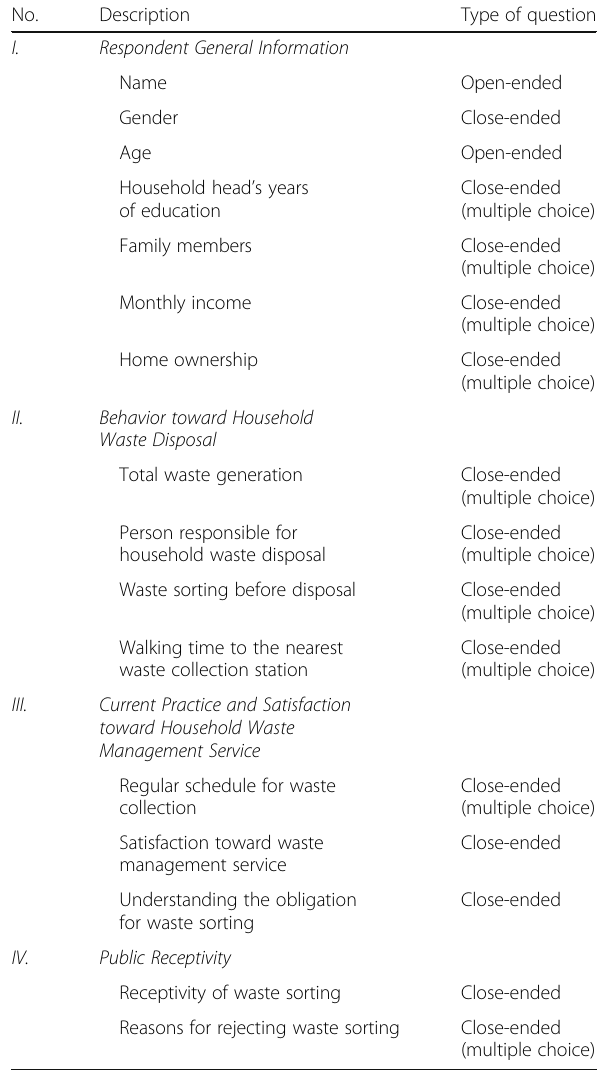
Table 1 Questionnaire design